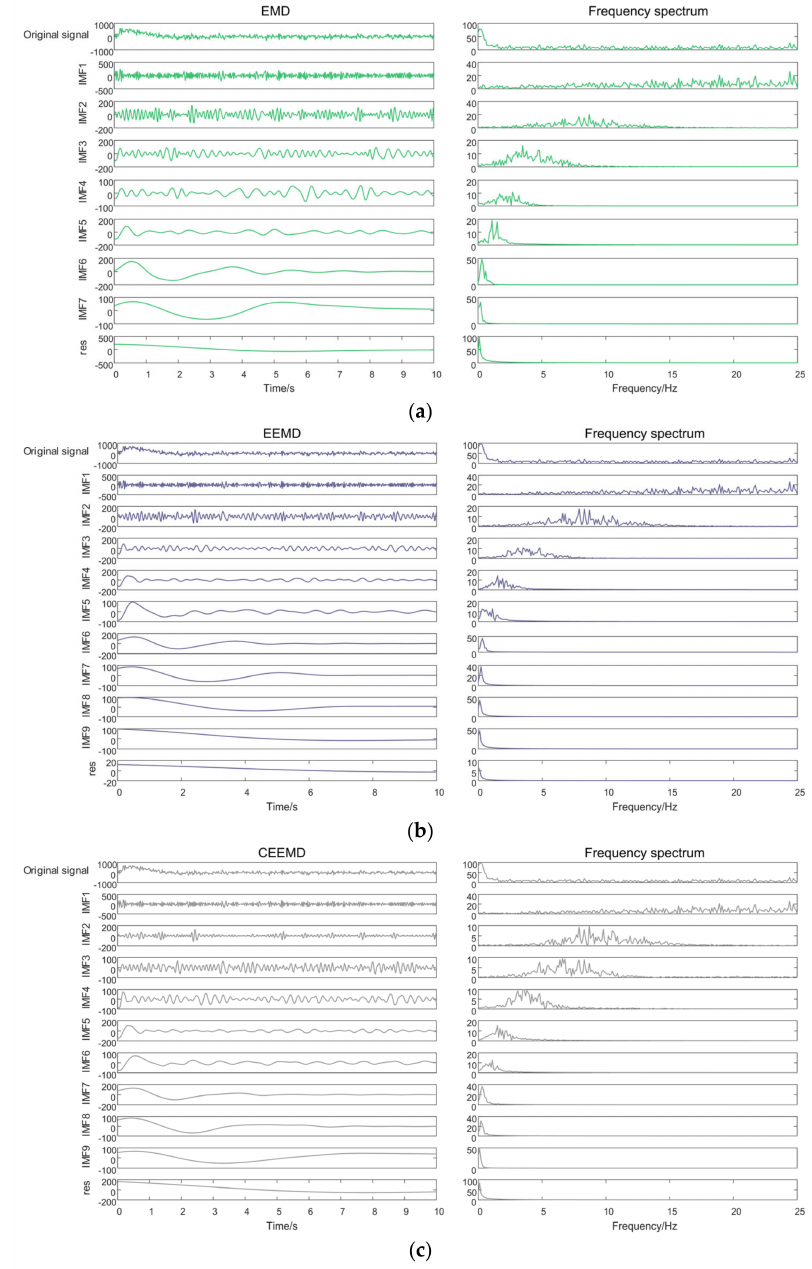
Figure 7. Simulation signal decomposition: ( a ) EMD; ( b ) EEMD; and ( c )